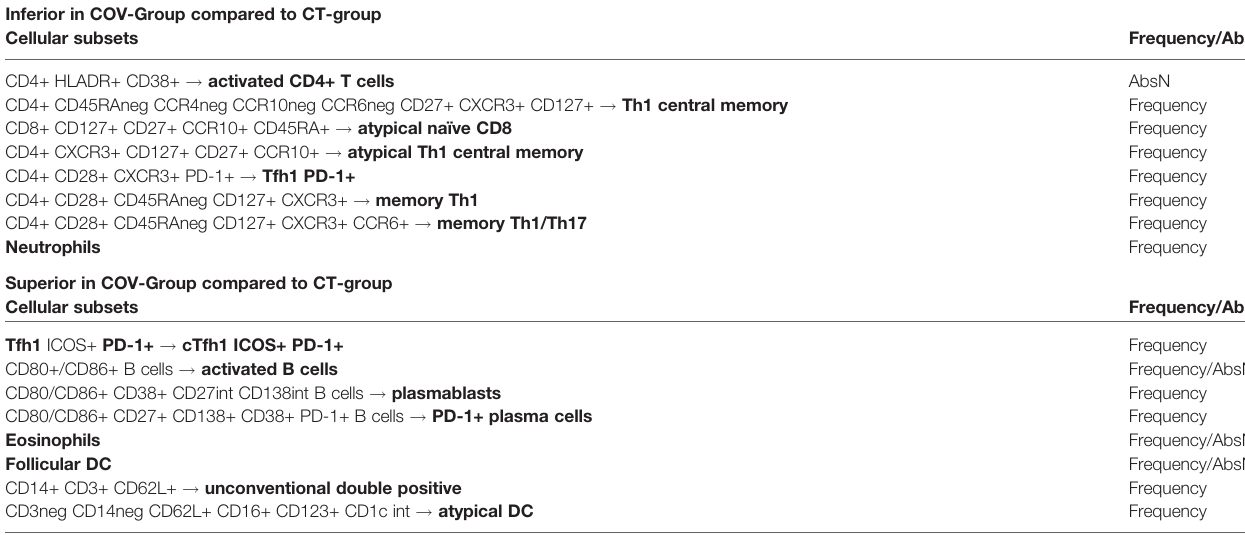
TABLE 2 | Summary of the principal cellular subsets signi fi cantly and differentially abundant between COV and CT group individuals. Inferior in COV-Group compared to CT-group Cellular